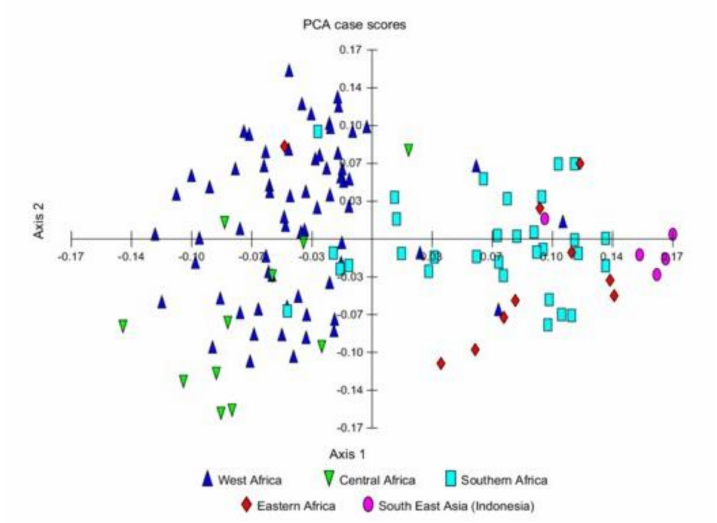
Figure 1. Principal coordinate analysis (PCA) scatter plot for 123 bambara groundnut landraces from Africa and Southeast Asia (Indonesia) based on 12 SSR markers used to determine population structure. Used with permission from